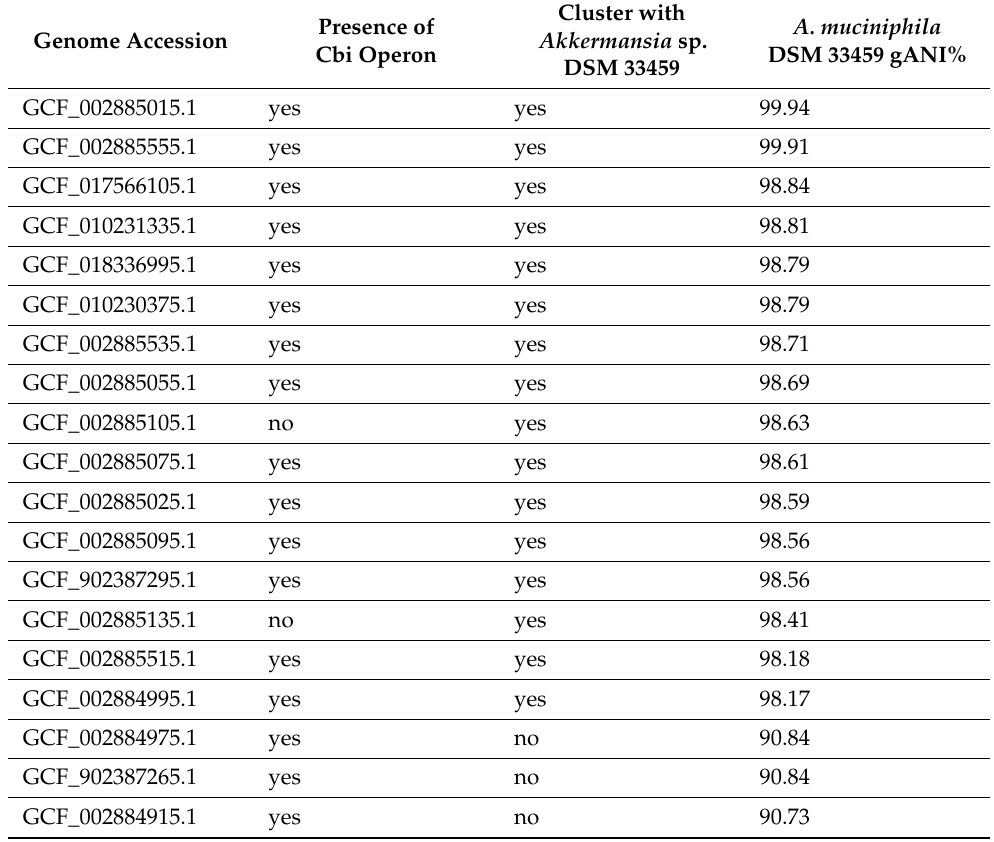
Table 4. Genome comparison based on Corrin ring biosynthesis gene cluster. Genome Accession